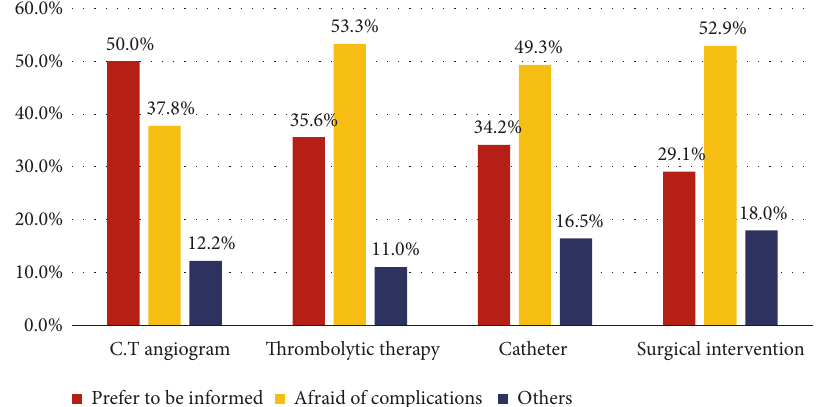
Figure 1: Causes of refusing undergoing the different stroke procedures directly without informing patients/relatives as recorded by general population shared in preference and values of stroke intervention, Kingdom of Saudi Arabia,